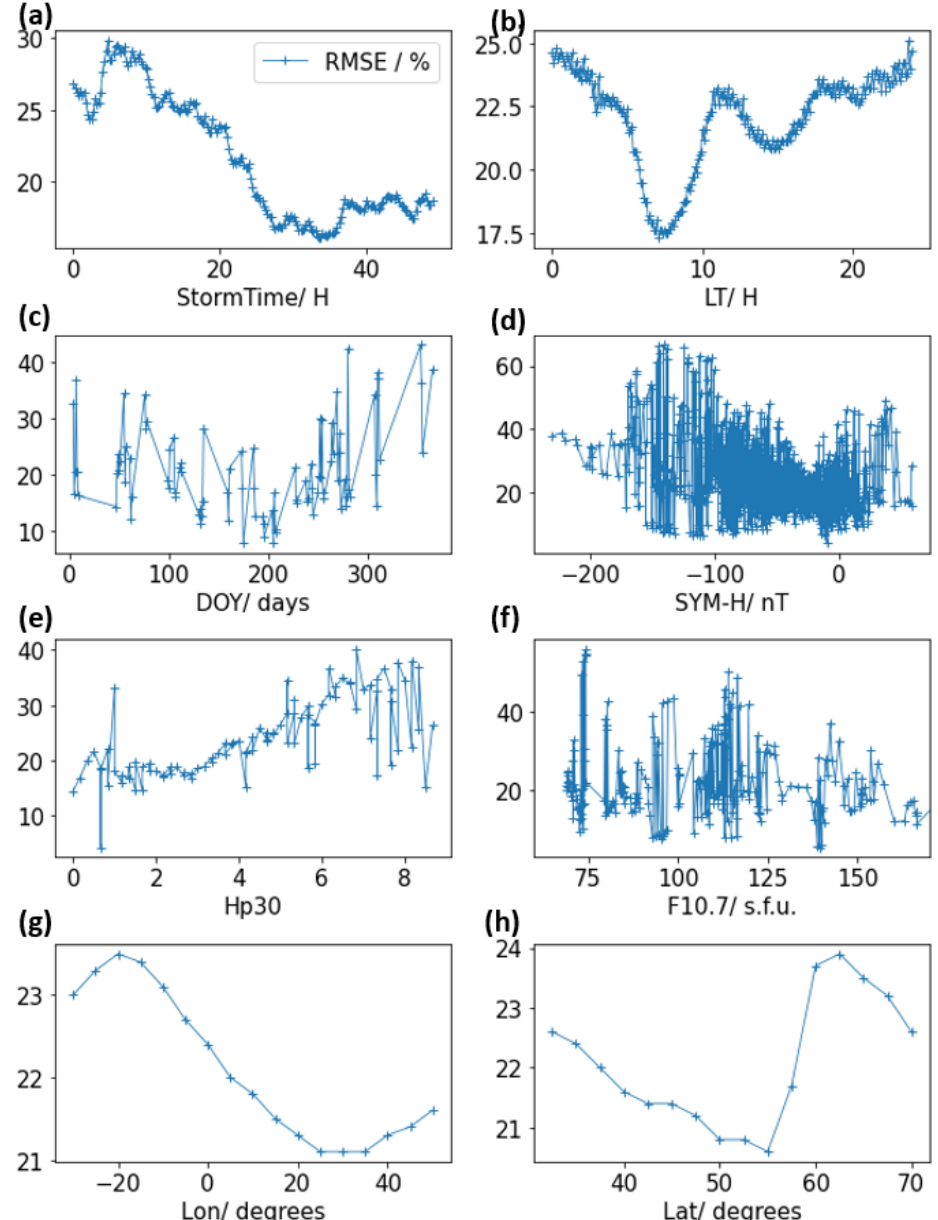
Figure 12. The RMSE of the relative TEC plotted for different parameters which are the storm time ( a ), local time ( b ), DOY ( c ), SYM-H ( d ), Hp30 ( e ), F10p7 ( f ), longitude ( g ) and latitude ( h ) for all the storms in the test